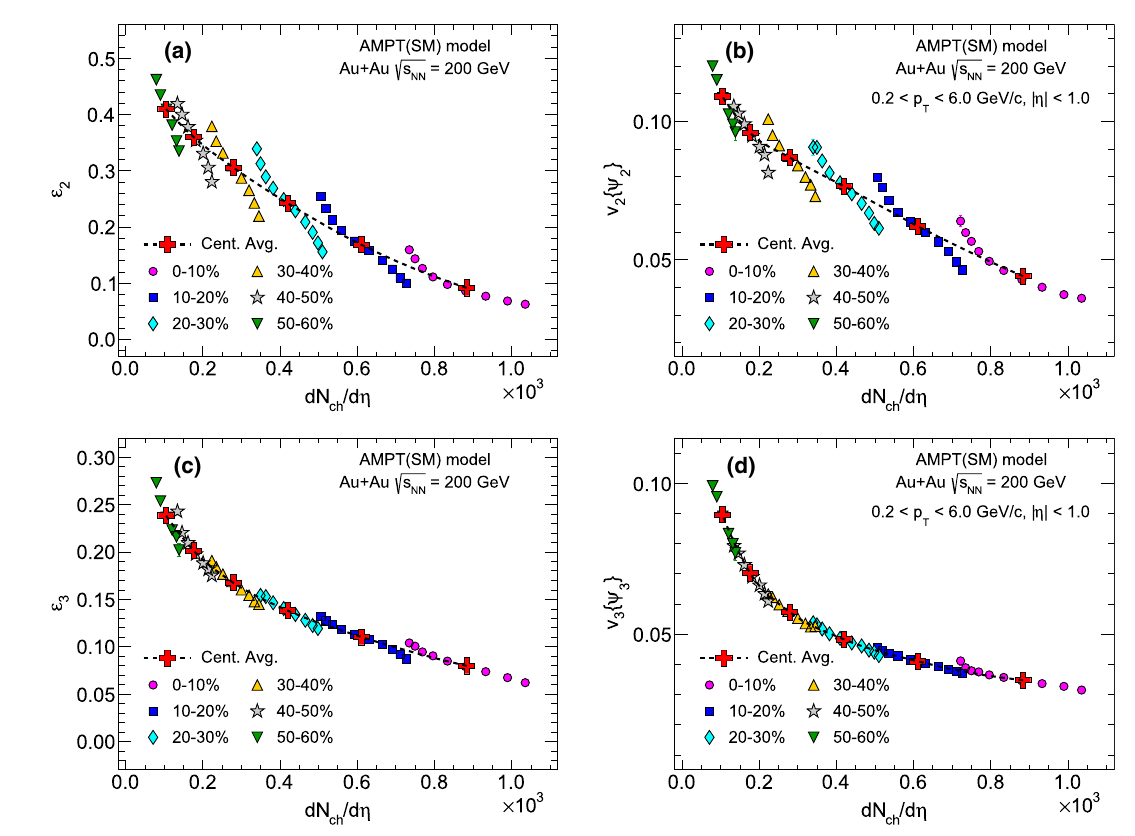
√ s NN = 200GeV. ues are shown by the “ + ” symbol in red, whereas the values for L+R binning in each centrality are shown in solid circles of different